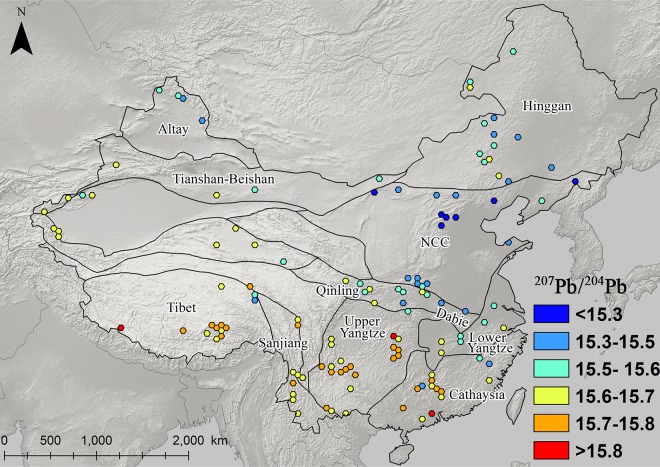
Map of 207Pb/204Pb ratios for galena ores (n = 2,104).